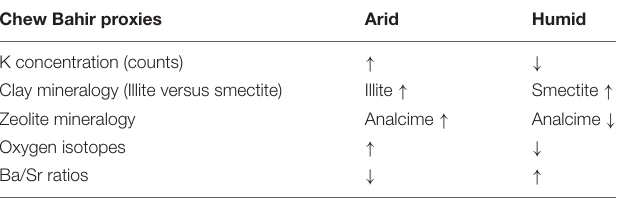
TABLE 4 | Arid and humid phases identified based on multi-proxy indicators. Chew Bahir proxies Arid